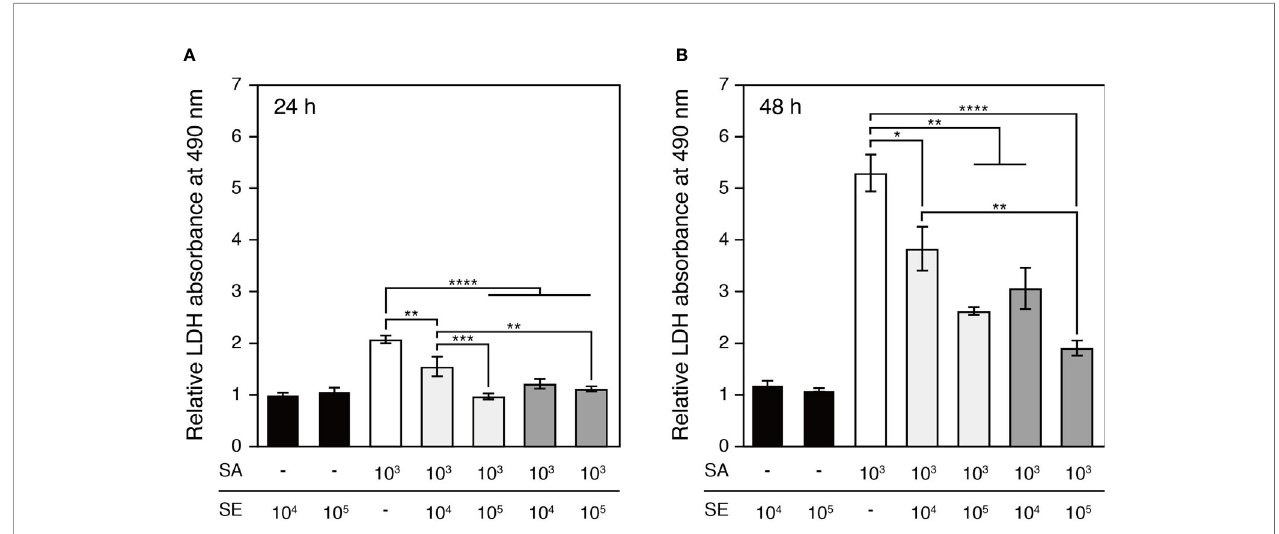
FIGURE 3 | Cytotoxicity elicited by the colonization of S. aureus and/or S. epidermidis after 24h (A) and 48h (B) cultivation. Cytotoxicity was quanti fi ed based on the activity of LDH released by the damaged keratinocytes. The S. aureus -colonized epidermal tissue exhibited a signi fi cantly elevated level of cytotoxicity in comparison to the S. epidermidis -colonized tissues. The S. aureus -induced cytotoxicity was attenuated by the colonization of S. epidermidis to an increasing degree as S. epidermidis was inoculated at a greater infective dose or prior to S. aureus . SE, S. epidermidis (black bars); SA, S. aureus (open bars). Light grey bars: S. epidermidis and S. aureus were inoculated simultaneously; dark grey bars: S. epidermidis was inoculated 4h prior to S. aureus . Data are presented as mean ± S.E. (n = 3-6). *p ≤ 0.05, **p ≤ 0.01, ***p ≤ 0.001, ****p ≤ 0.0001. Tukey – Kramer Post Hoc test after One-way analysis of variance